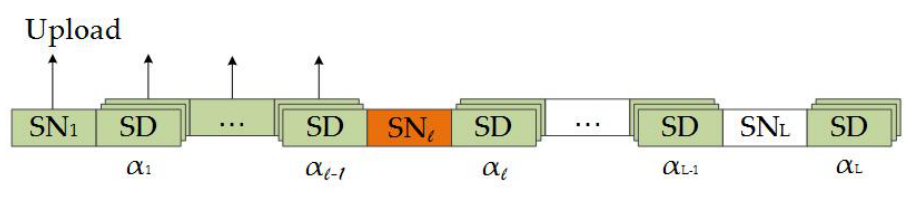
Figure 7. The status of the reordering buffer after the transmission in Category 2.